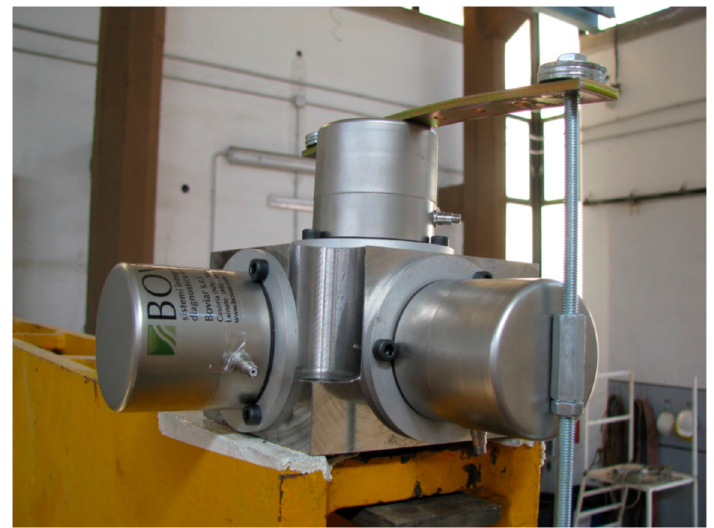
Figure 13. Detail of the positioning of the accelerometers at the end of the beam. Table 10. Experimental eigenfrequencies of the steel frame.